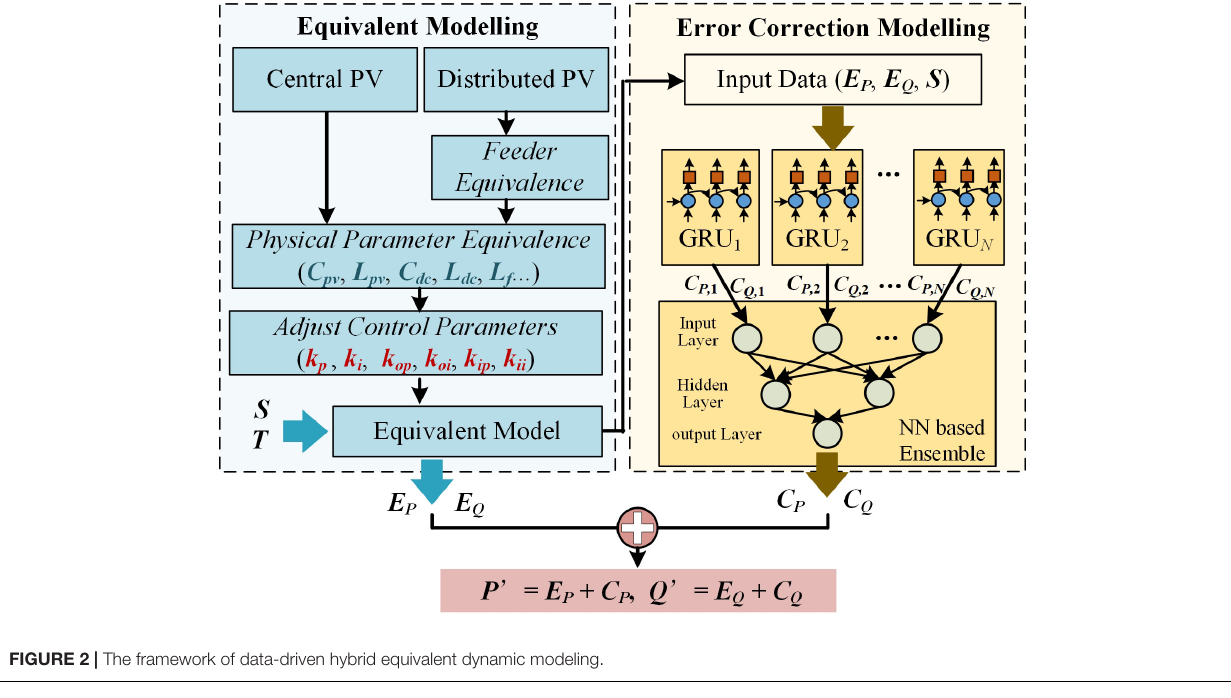
FIGURE 2 | The framework of data-driven hybrid equivalent dynamic modeling.